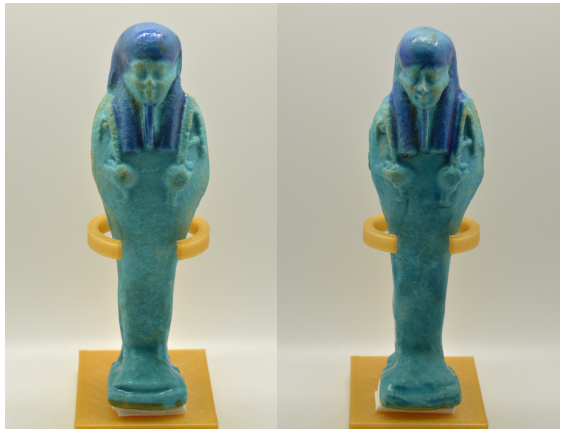
Figure 5. Two shabtis for the same person, probably Petosiris. XXX dynasty (380 BC–343 BC), Late-Ptolemaic Period. Private